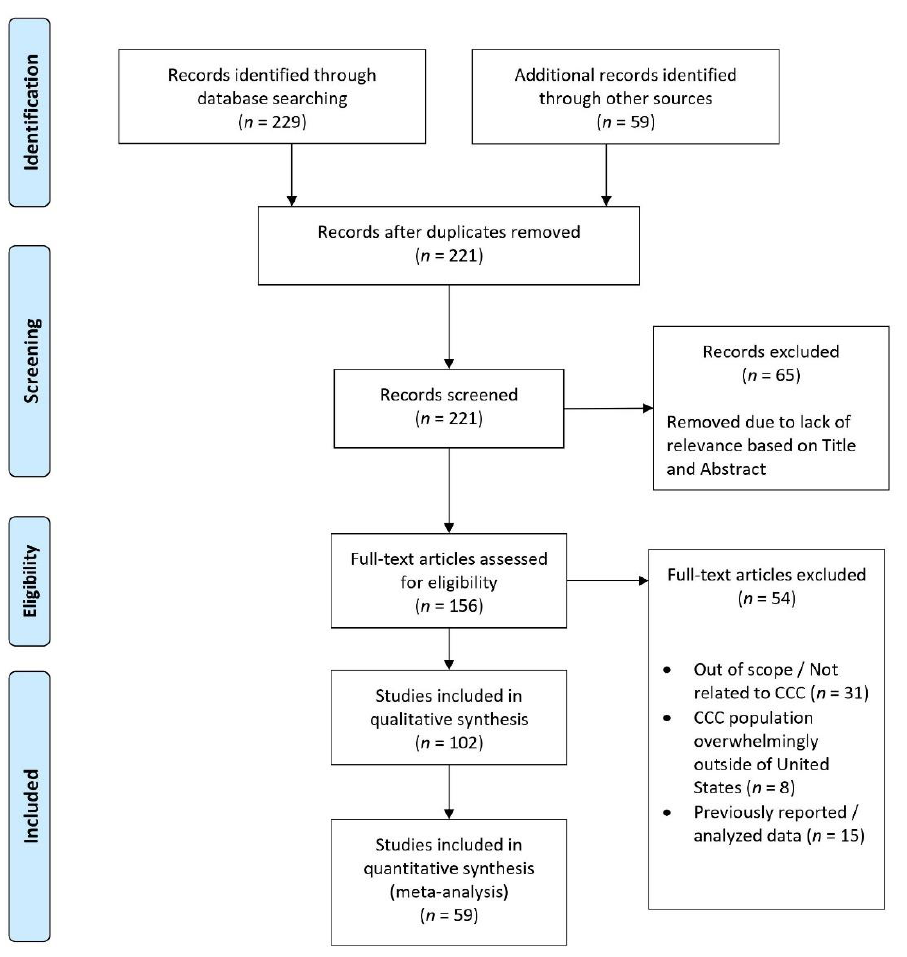
Figure 1. Flow diagram of search and study selection. Table 1. State Cancer Plans in the United States and Plans for Implementation, all access 31 August